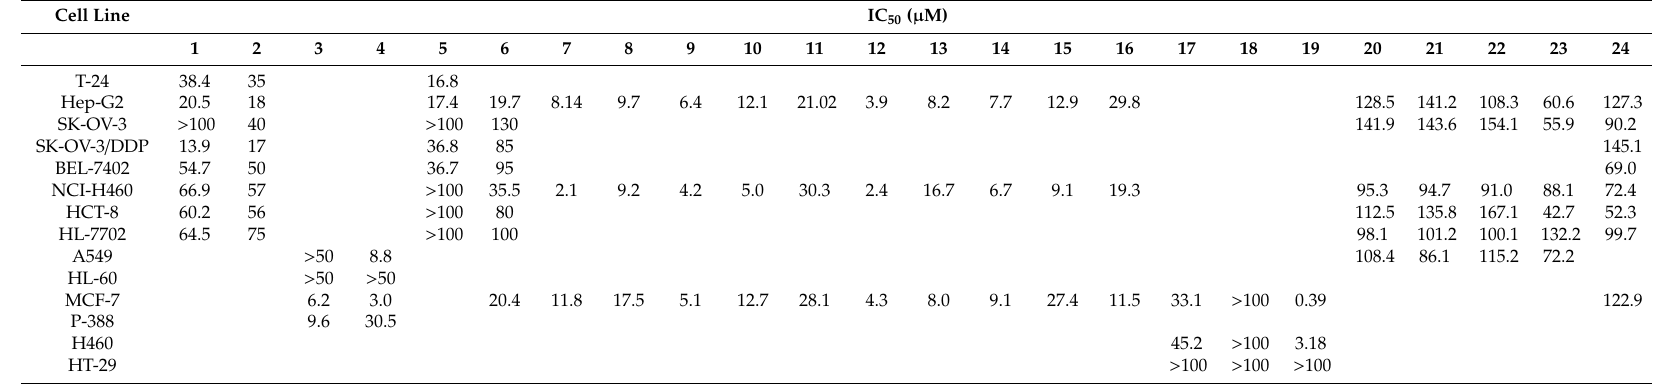
Table 1. Toxicity test of oxoisoaporphine derivatives in several line cancer